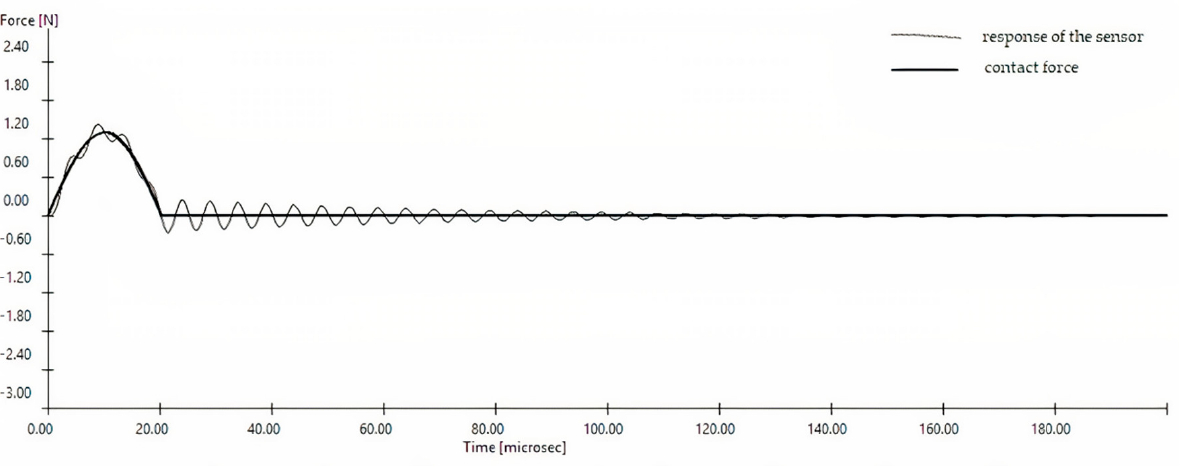
Figure 7. The course of the impact force and measurement signal from the sensor for a large dry grain. Contact stiffness k 2 = 1 × 10 5 Nm − 1 , f rez = 200 kHz.